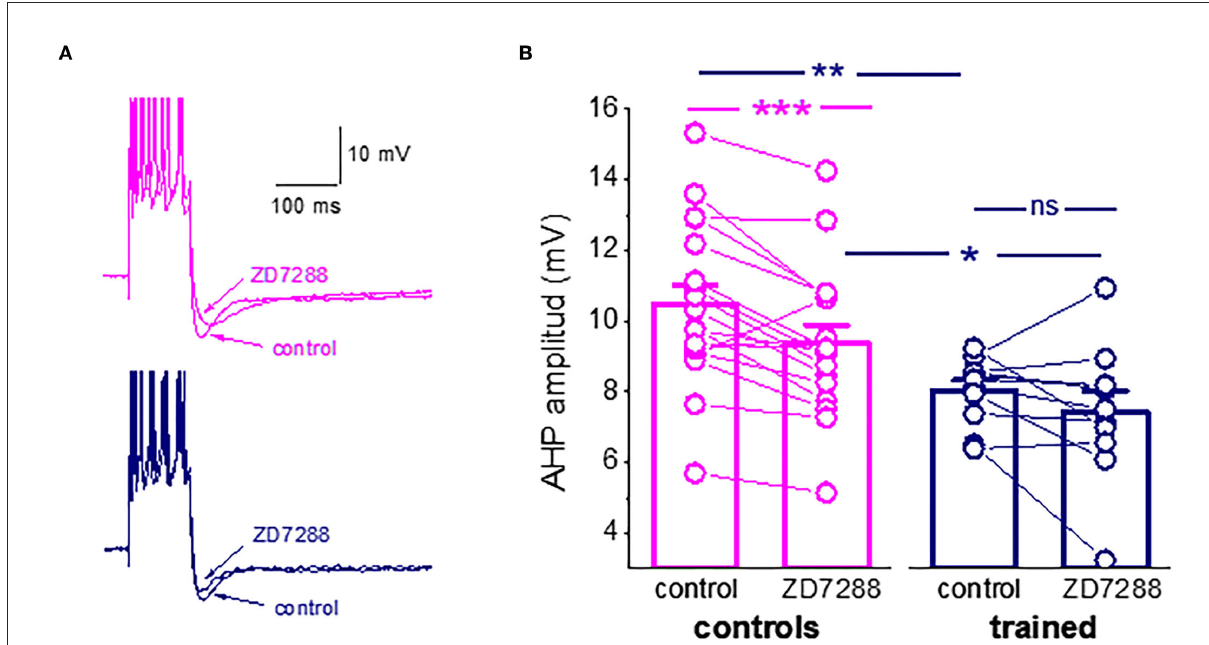
FIGURE3 I h is active during the post-Burst AHP in neurons from control rats. (A) Averaged traces from pseudo-trained and trained neurons, before and 20min after the ZD7288 application. The I h blocker reduced the post-burst AHP in the pseudo-trained neuron only. (B) The I h blocker, ZD7288, reduces the post-burst AHP amplitude in neurons from the controls, but not from the trained rats. Bars represent mean ± SE. ** p < 0.051. * p < 0.05. A paired t -test was used to compare the effect of ZD7288 of each group of neurons. An unpaired t -test was used to examine the difference between neurons from the trained and control rats. *p < 0.05; **p < 0.01; ***p < 0.001; ns, not